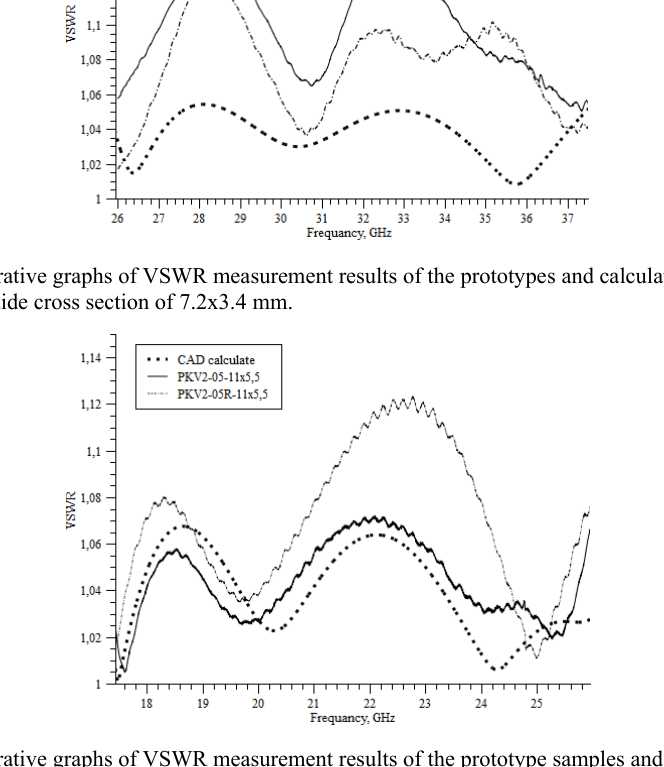
Fig. 5. Comparative graphs of VSWR measurement results of the prototype samples and calculated value for the waveguide cross section of 11 x 5.5